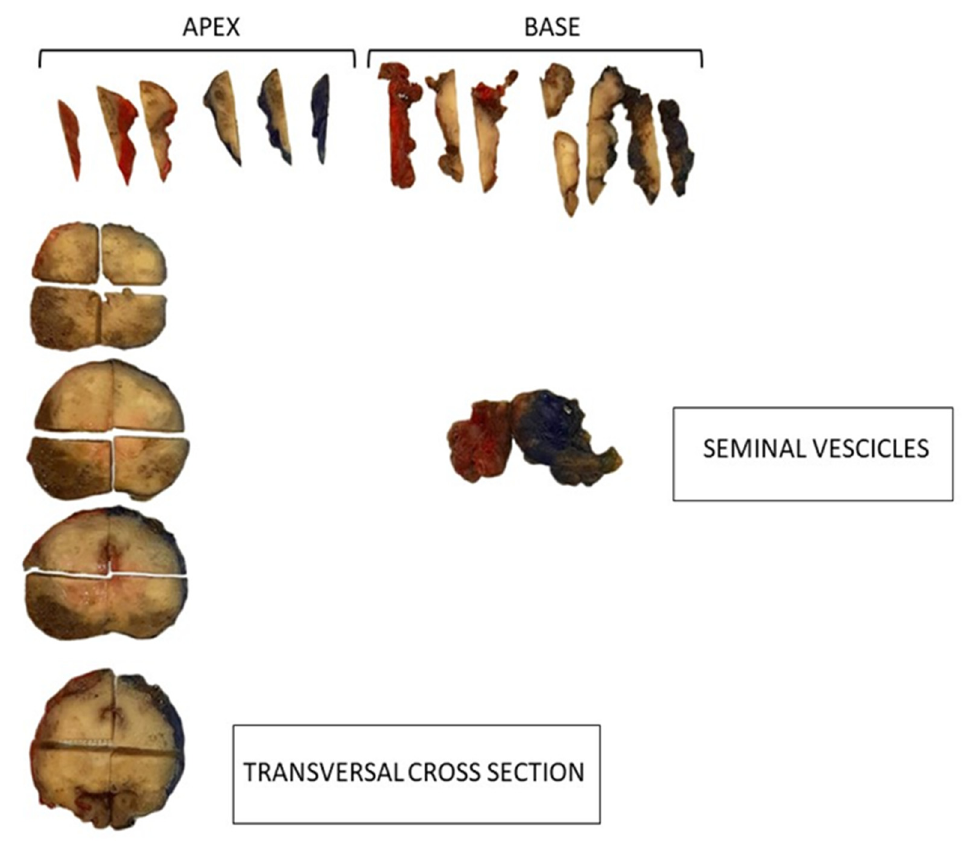
Figure 1. Prostatic specimen sectioned according to international grossing protocols for pathological examination.